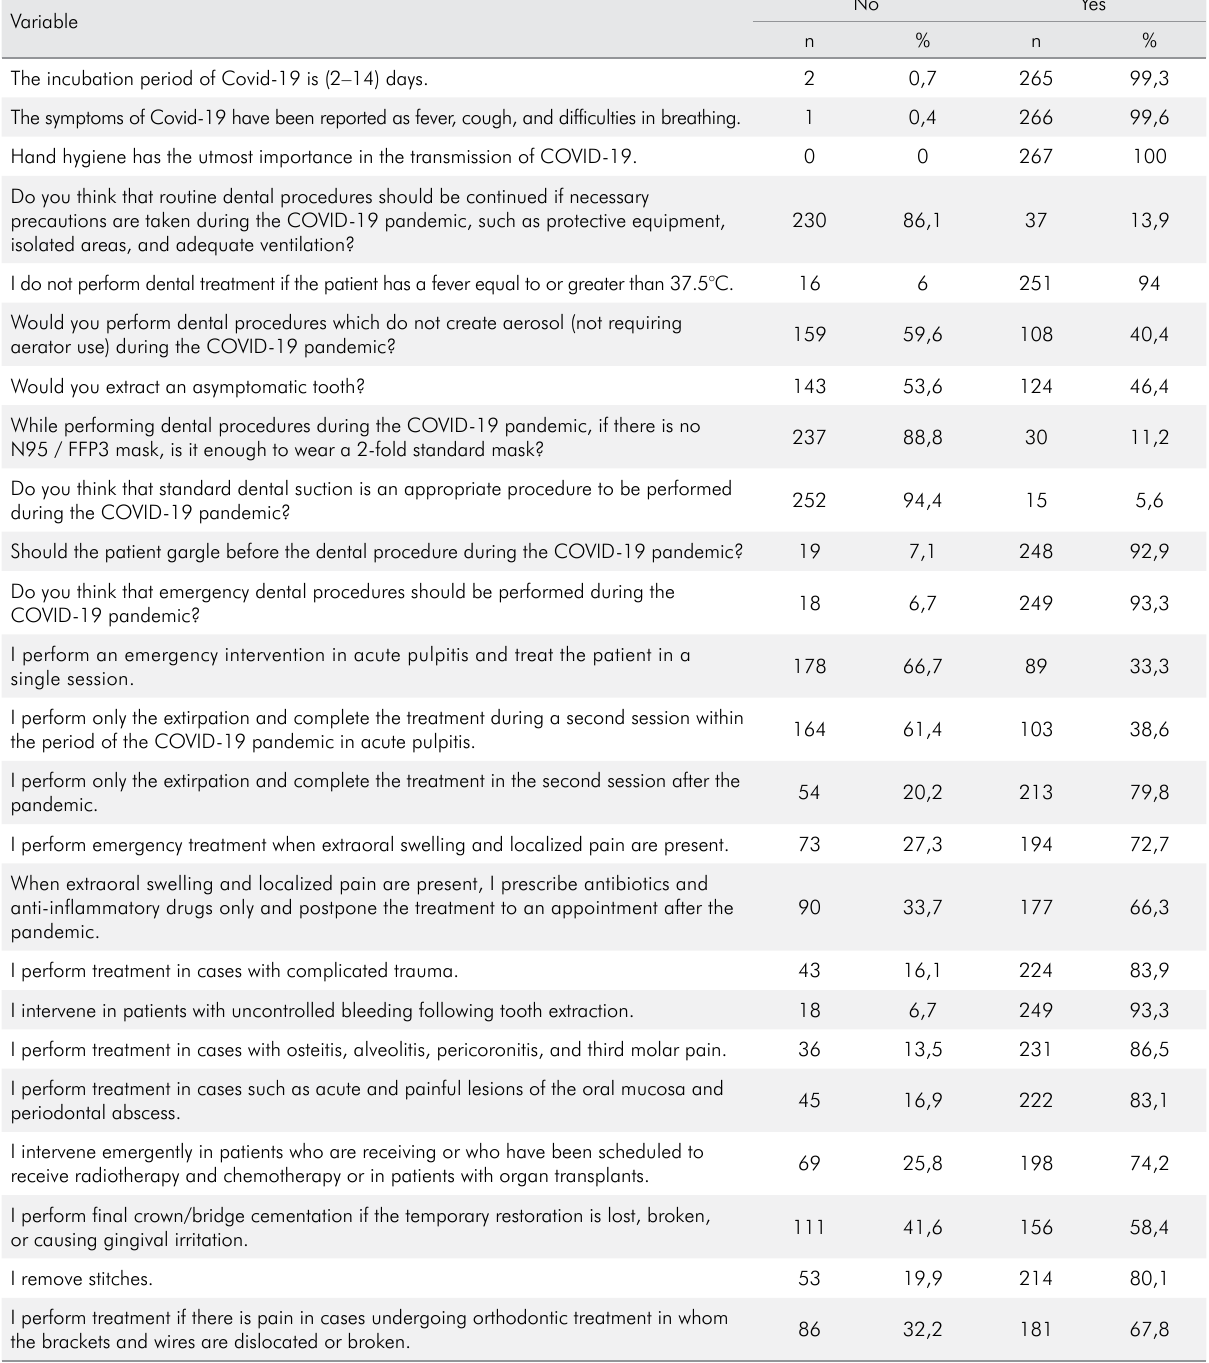
Table 5. Distribution of dentists’ knowledge on COVID-19 Variable